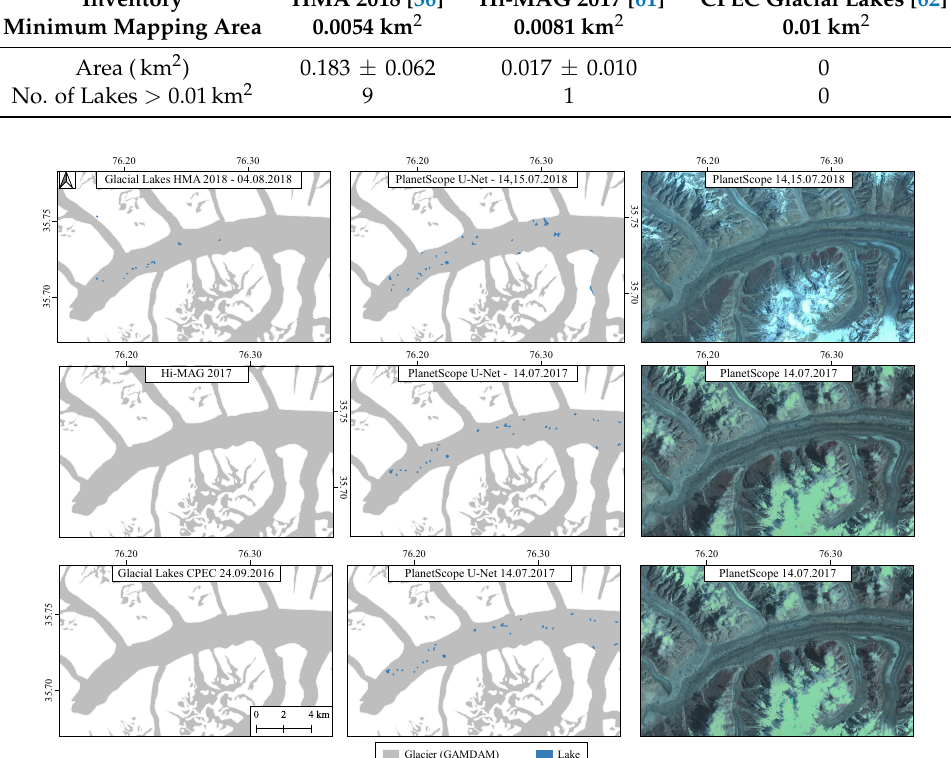
Table 4. Supraglacial lakes on the Baltoro glacier available in: (1) glacial lakes inventory of High Mountain Asia [36], (2) a dataset of glacial lakes in High Mountain Asia (Hi-MAG) from 2008 to 2017 [61] and (3) glacial lakes in the China–Pakistan Economic Corridor (CPEC) [62]. All of these inventories used Landsat-8 data.